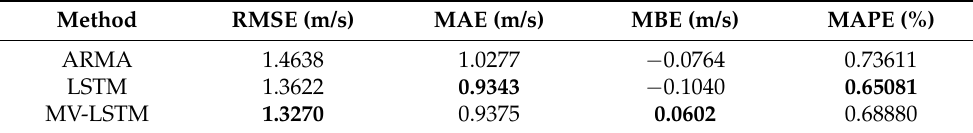
Table 6. The evaluation metric values for three models on the test set of Zhaitang